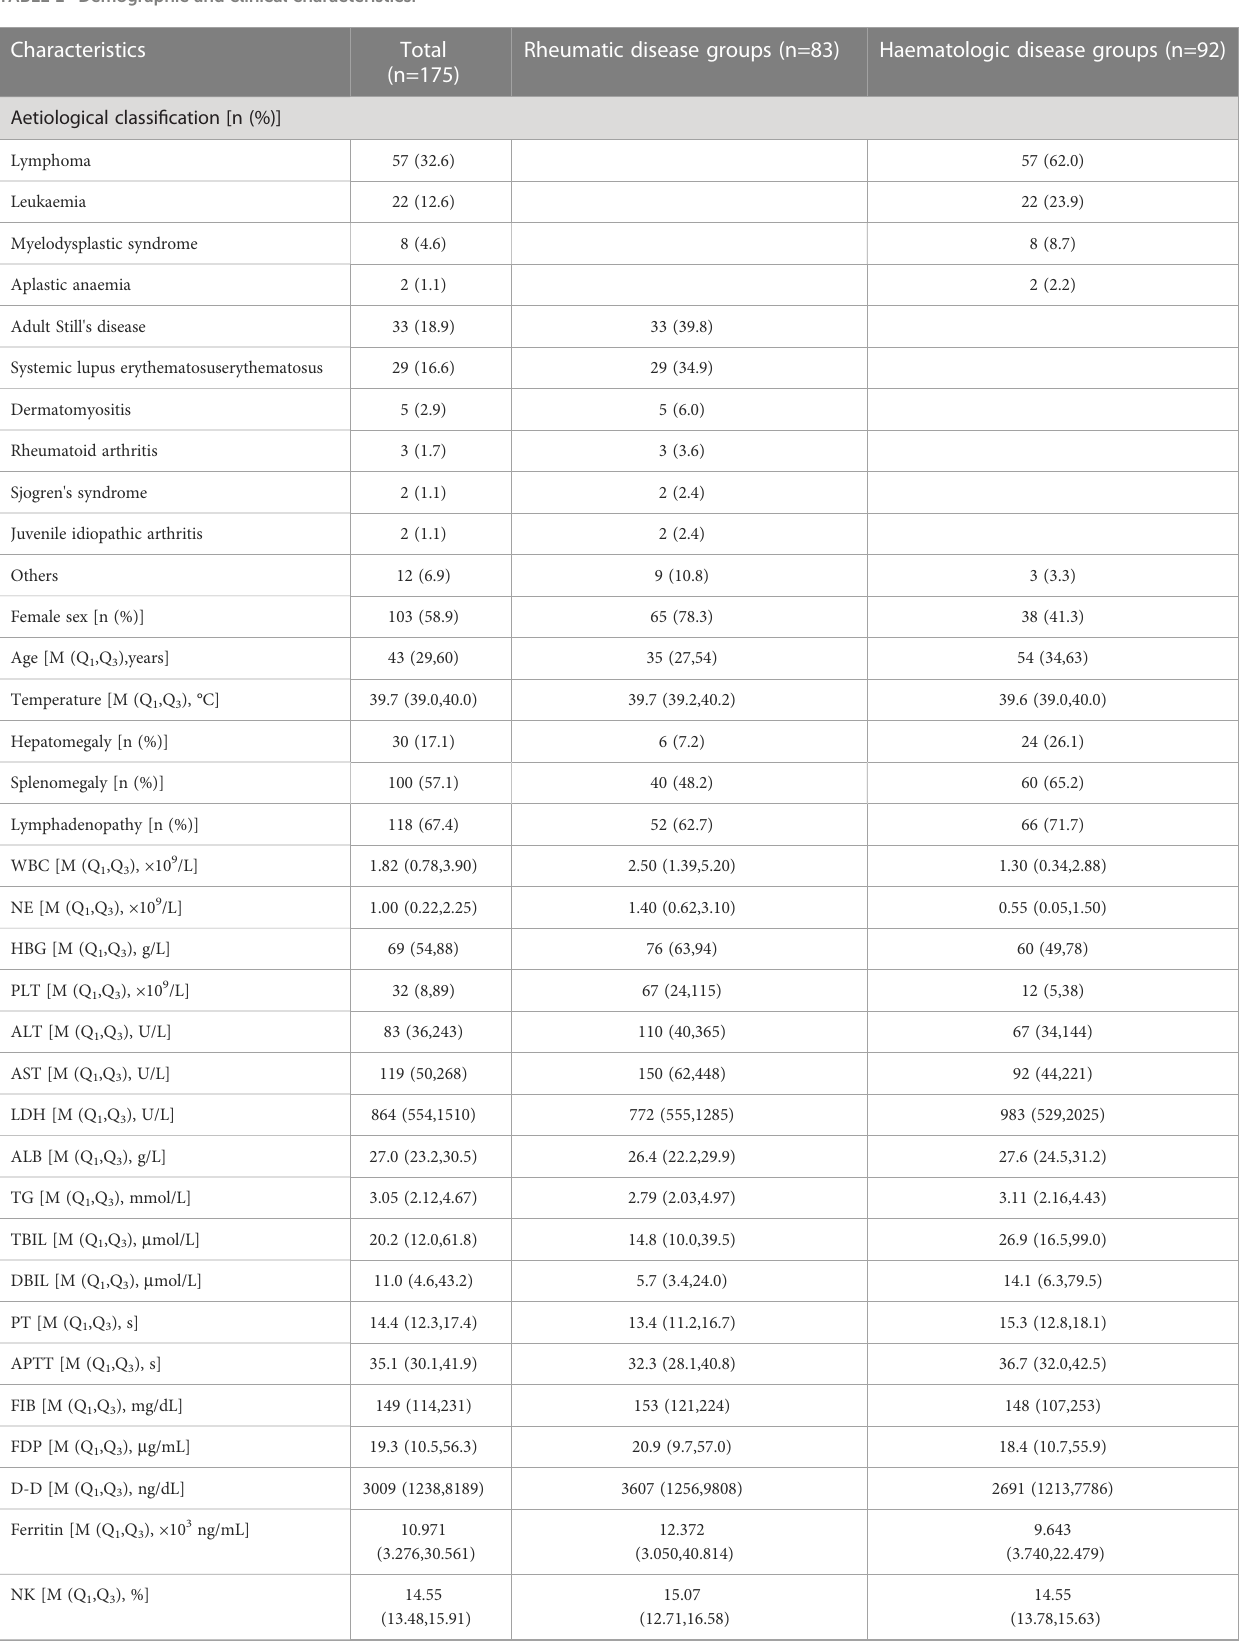
TABLE 1 Demographic and clinical